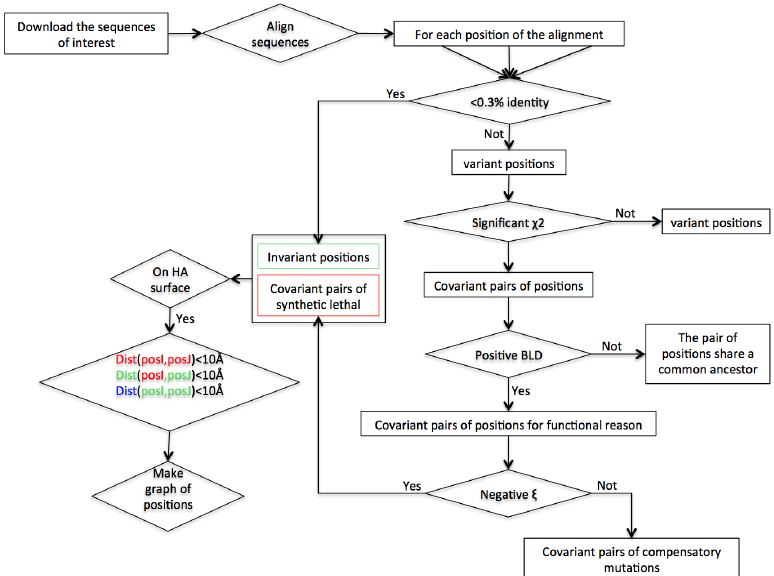
Figure 1. Workflow of the bioinformatic and statistical methods. Data are in rectangles, and processes in diamonds. Dist (posI, posJ) expresses the physical distance between a position I and a position J. The objective of this workflow is to determine the lethal synthetic pairs (in red in the diagram) and the invariant positions (in green in the diagram) nearby to make a graph (Figure 3), where the edge between two invariant positions will be blue, between two positions SL will be red and between an invariant position and a synthetic lethal will be